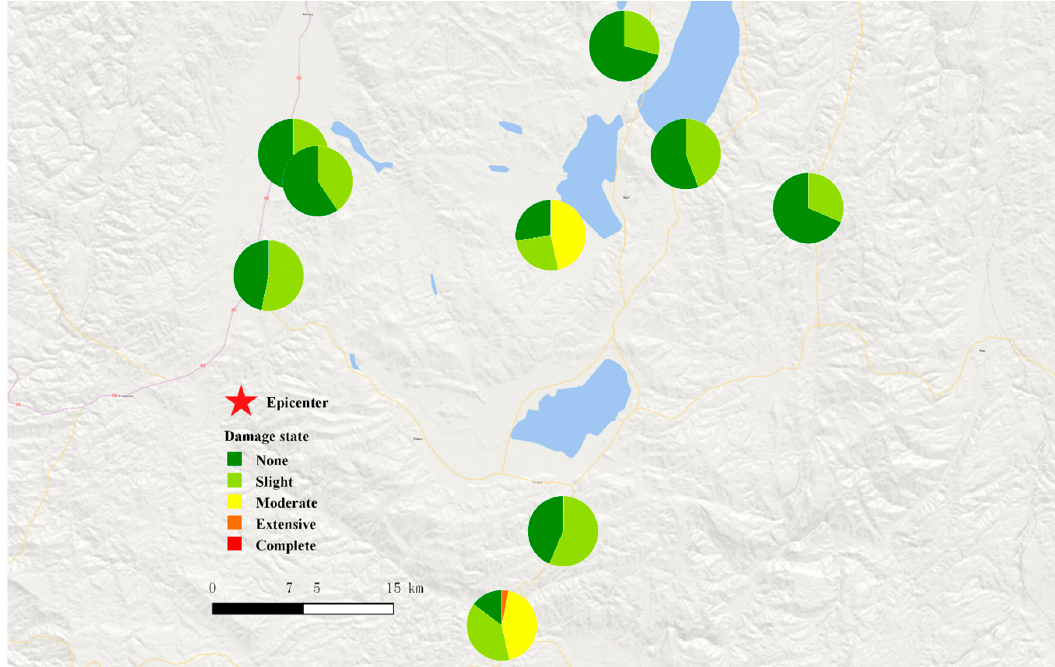
Figure 5. Destructive power of ground motions of the 08/13/2018 M5.0 Yunnan Tonghai earthquake.